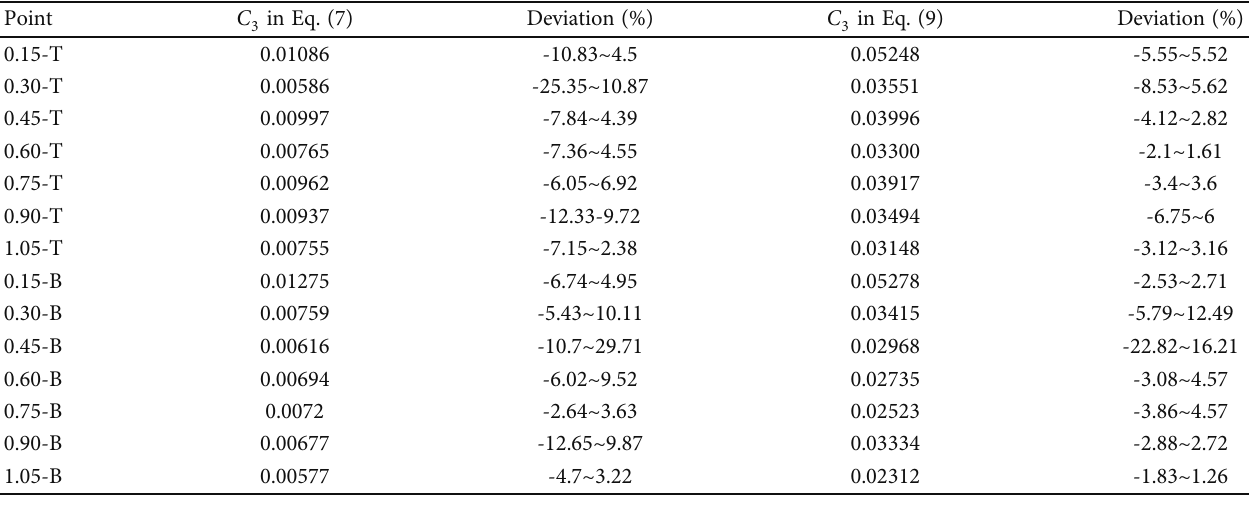
Table 6: C values and deviations. 3